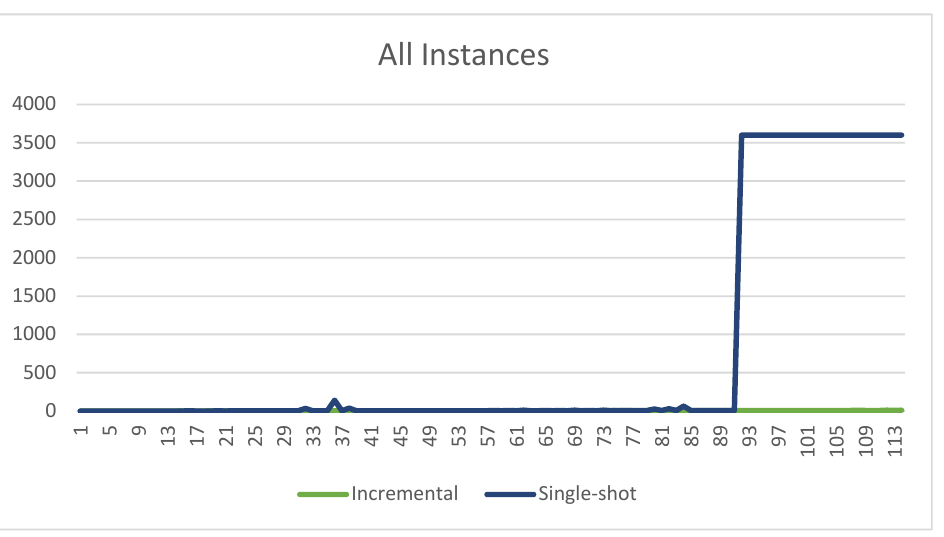
Figure 2. Comparison of the execution times for all